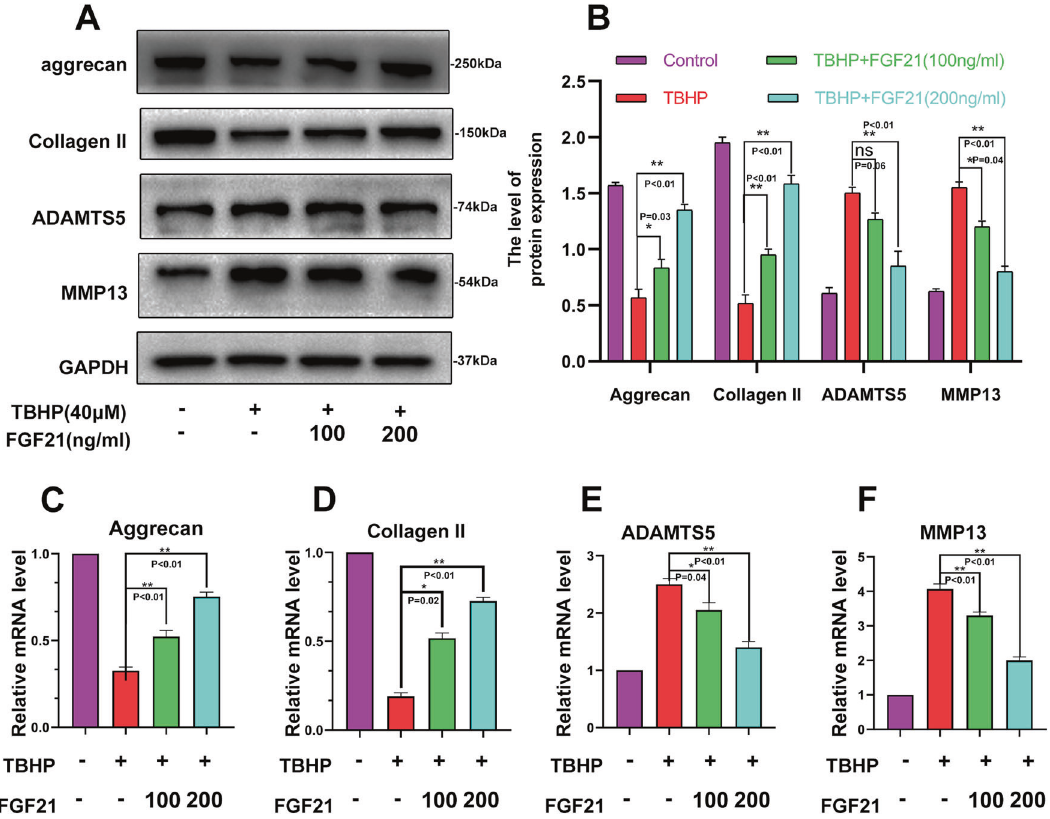
Fig. 2 FGF21 treatment inhibited the TBHP-induced catabolism of the ECM. A , B Shown is the change in the levels of Aggrecan, Collagen II, ADAMTS5, and MMP13 in the chondrocytes, evaluated by the western blot analysis. C – F Shown is the mRNA expression of Aggrecan, Collagen II, ADAMTS5, and MMP13 in the chondrocytes treated with TBHP and TBHP plus FGF21, measured using real-time PCR. The data in the fi gures are the averages ± S.D. Signi fi cant differences between the treatment and control groups are indicated as ** P < 0.01 and * P < 0.05, n =